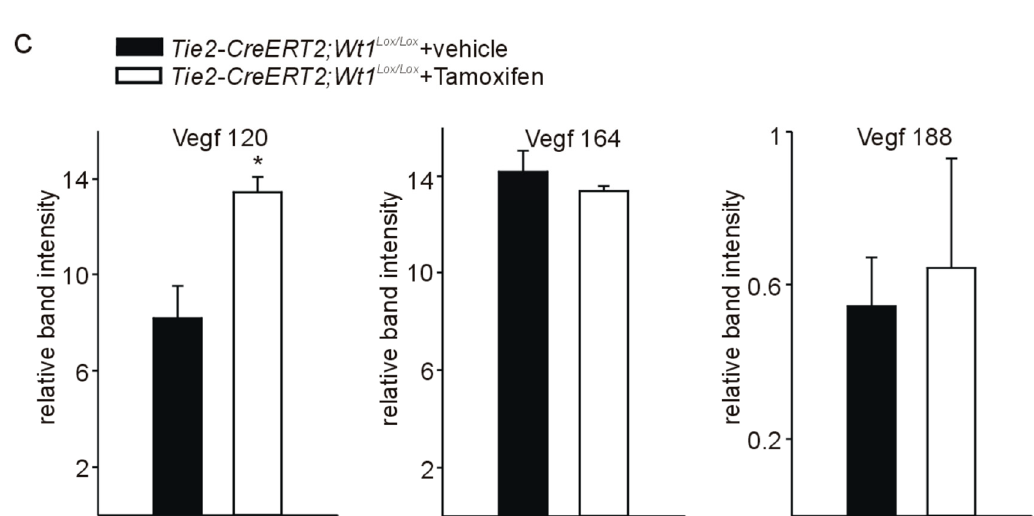
Figure 4. Reduced expression of Wt1, Srpk1, and Srsf1 and altered Vegf splicing in tumor endothelial cells of Tie2-Cre ERT2 ; Wt1 Lox/Lox mice treated with Tamoxifen compared to vehicle-treated controls. ( a ) Expression levels of Wt1, Srpk1, and Srsf1 were determined by quantitative RT-PCR on isolated endothelial cells of tumors from Tie2-Cre ERT2 ; Wt1 Lox/Lox mice treated with Tamoxifen compared to vehicle-treated controls ( n = 6 each). Expression of each gene was normalized to the respective arithmetic means of Gapdh , Actnb, and Rplp0 expression. ( b ) Expression of the different Vegf isoforms (Vegf 188: 293 bp; Vegf 164: 221 bp; Vegf 120: 89 bp) was determined on isolated endothelial cells ( n = 3 each) as described [18]. ( c ) Quantification of relative band intensities revealed relative higher Vegf120 isoform levels, while Vegf164 and Vegf188 were not significantly affected by the knockout of Wt1. Data are expressed as means ± S.E.M. * p < 0.05, ** p <